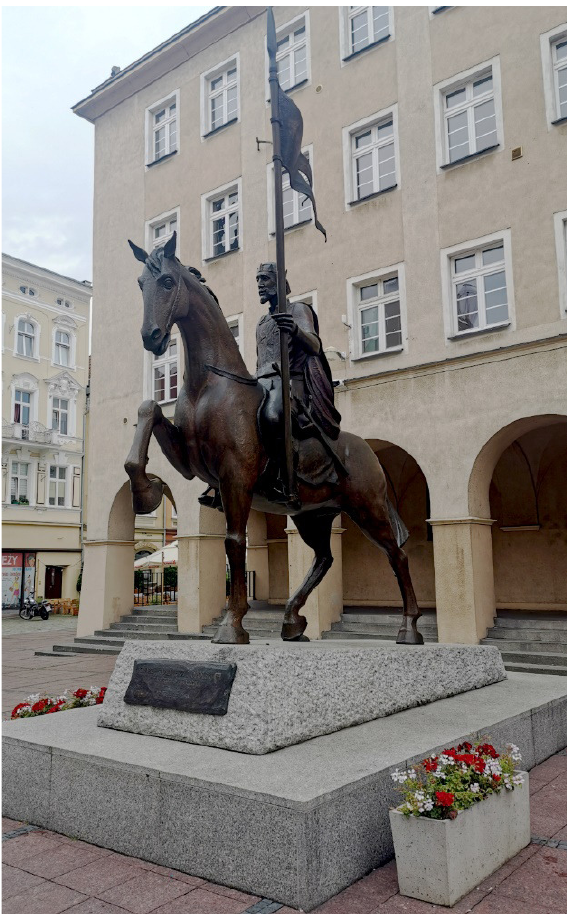
Figure 7. Monument of Casimir I of Opole. Figure 8. Monument of Frederick the Great. Source: Wikimedia Commons